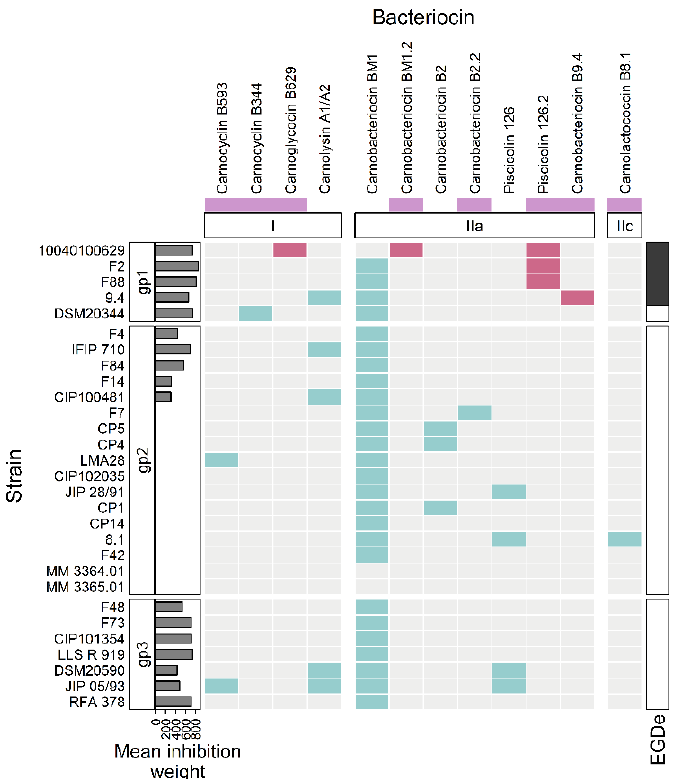
Figure 5. Heatmap representing the occurrence of bacteriocin BGCs in the genomes. The strains of C. maltaromaticum (in rows) are grouped according to the groups “gp1”, “gp2”, and “gp3”. The considered bacteriocin BGCs (in columns) are grouped according to the class of bacteriocin to which they belong (class I, IIa, IIc). The mauve boxes, below the bacteriocin names, denotes newly described bacteriocins in this study. The barplot annotation on the left represents the mean inhibition weight (in min) of C. maltaromaticum receiver strains by the sender strains. In the annotation block on the right, black boxes indicate inhibition of L. monocytogenes EGDe by the C. maltaromaticum strains. The presence of a bacteriocin BGC is indicated by turquoise or red cells. The red cells denote bacteriocin BGCs specifically found in C. maltaromaticum strains with anti- L. monocytogenes activity, the other BGC are denoted in turquoise. Table 1. Bacteriocins predicted from the genome of 29 strains of C. maltaromaticum.